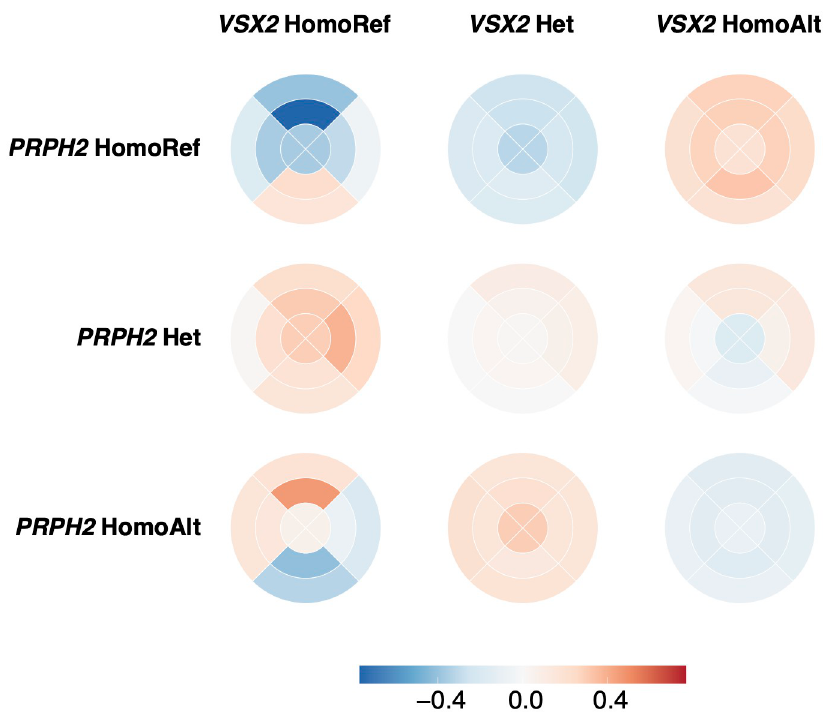
Fig 8. Normalised thickness of ONL stratified by VSX2 and PRPH2 genotype. The mean thickness of the ONL at each of the nine segments of the ETDRS grid across individuals stratified by their genotype at VSX2 and PRPH2 . The thickness is mean normalised per VSX2